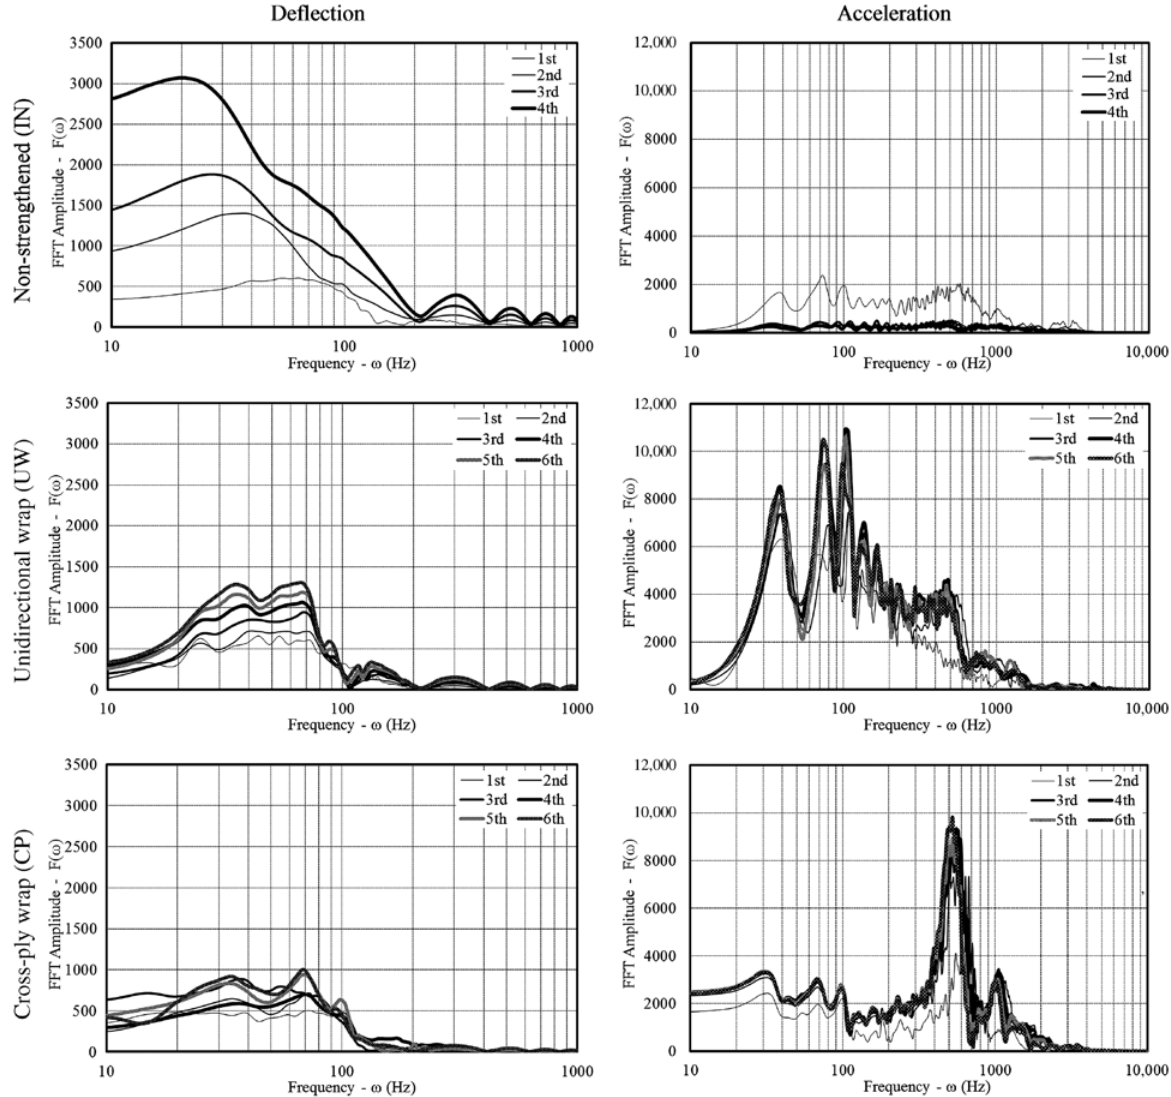
Figure 6: FFT amplitude vs. frequency distribution of midspan deflection and